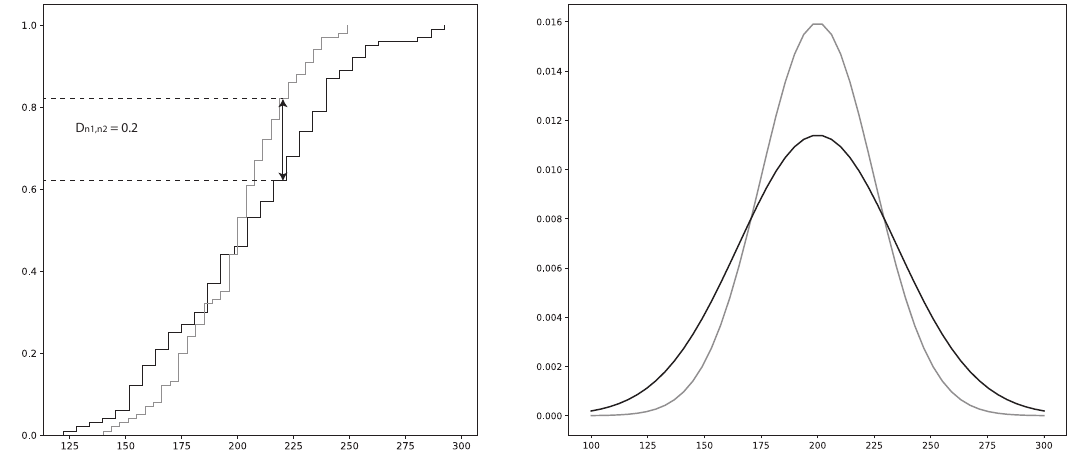
Figure 6. An illustration of the two-sample Kolmogorov–Smirnov (KS)-test for the random variables X1 and X2, where X 1 ∼ Norm ( 200,25 ) and X 2 ∼ Norm ( 200,35 ) Left: The cumulative distribution functions (CDF) of X1 and X2 with the D-value as the difference between the upper and lower dashed lines. 100 samples were drawn from each distribution. Right: The probability density functions of X1 and